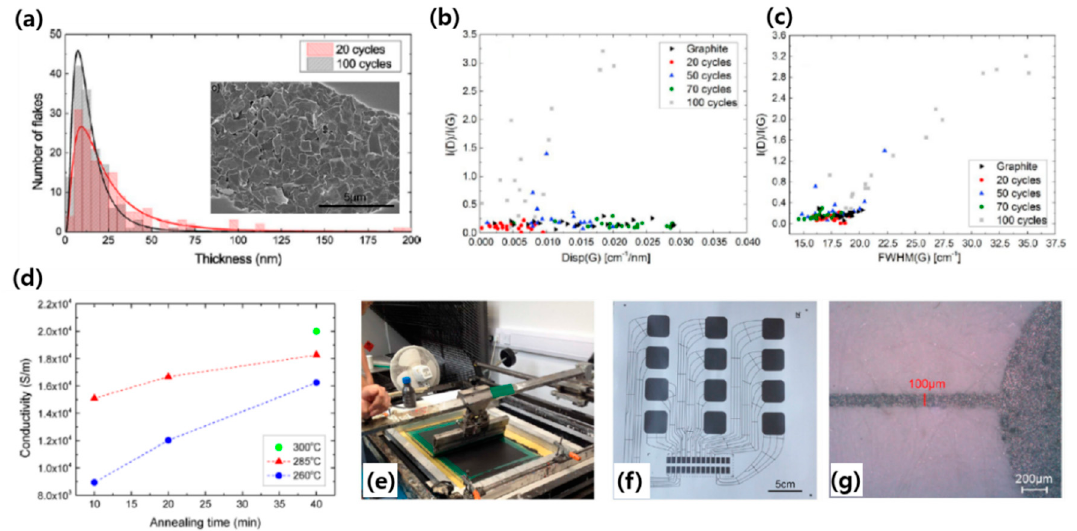
Figure 2. ( a ) Thickness distribution of exfoliated graphite nanosheets (inset: SEM ((scanning electron microscope) image of exfoliated graphite proceeded for 100 cycles), I(D)/I(G) as a function of ( b ) Disp(G) and ( c ) FWHM (Full width at half maximum)(G), ( d ) electrical conductivity as a function annealing time and temperature, ( e ) optical image of the screen printing process, ( f ) capacitive touchpad design (29 × 29 cm) printed on paper, and ( g ) a line on the touchpad. Reprinted with permission from reference [16], copyright 2017, American Chemical Society.